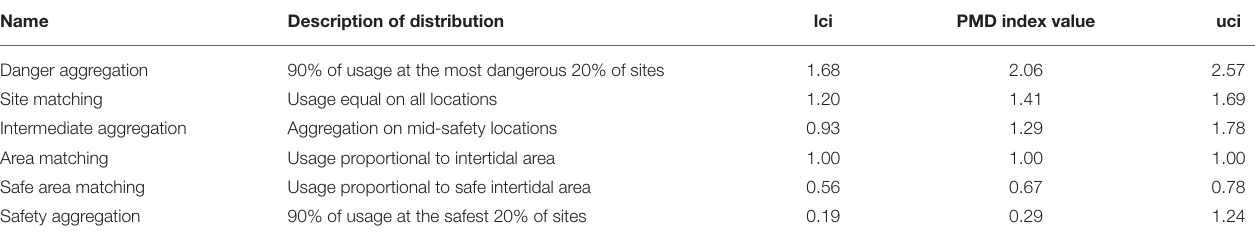
TABLE 1 | Simulated values of the PMD index as the usage distribution of semipalmated sandpipers over 100 simulated census locations.